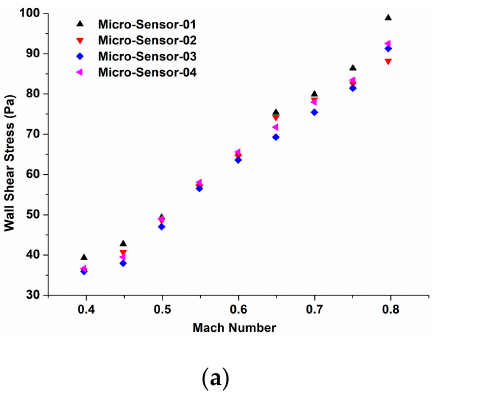
Figure 10. Comparisons of wall shear stress obtained by (9), the Preston tube, and the micro-sensor.